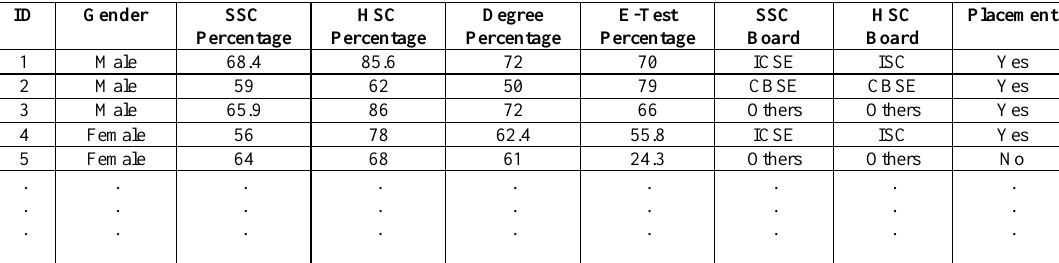
Table 1. Sample Indian business school